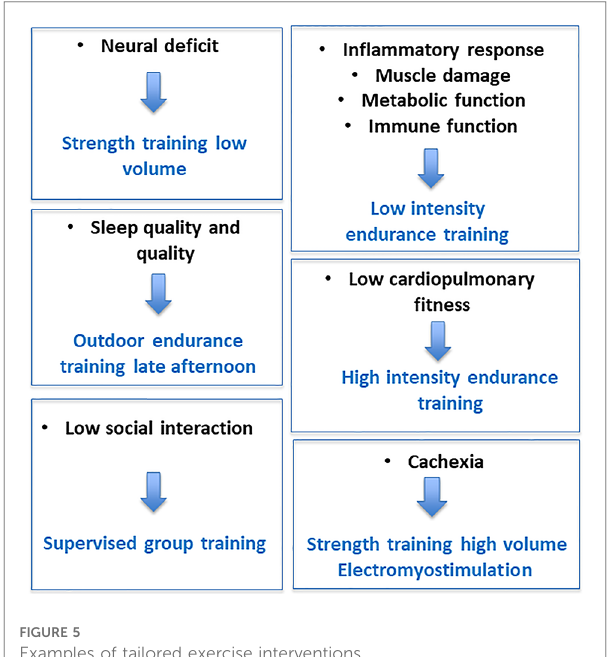
FIGURE 5 Examples of tailored exercise